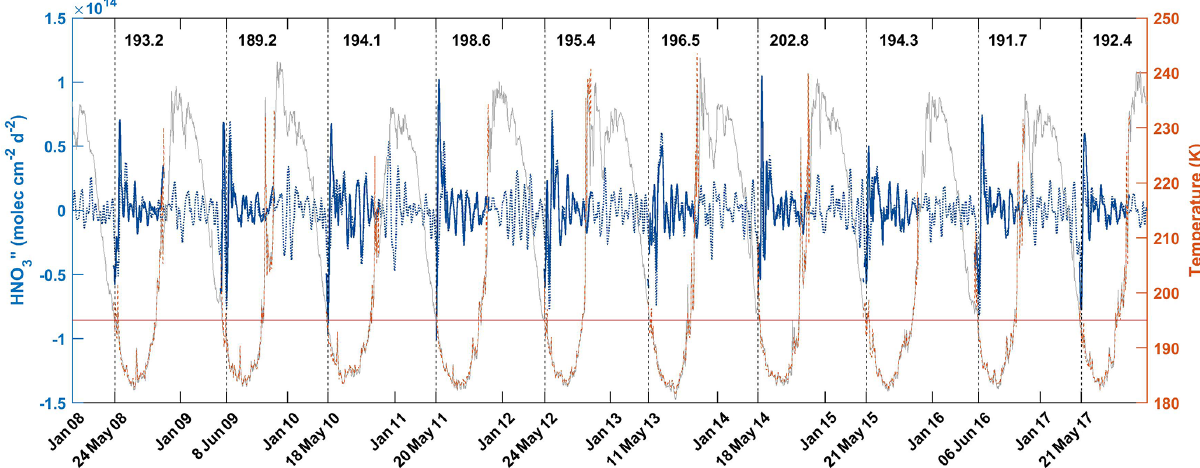
Figure 4. Time series of total HNO 3 second derivative (blue, left y axis) and the 50hPa temperature (red, right y axis) in the region of potential vorticity at 530K lower than − 10 × 10 − 5 Km 2 kg − 1 s − 1 . The horizontal red line corresponds to the 195K temperature. The vertical dashed lines indicate the second derivative minimum in HNO 3 for each year. The corresponding dates (in bold, on the x axis) and temperatures are also indicated. The time series of total HNO 3 second derivative (dashed blue) and of temperature (grey) in the 70–90 ◦ S eqlat band are also